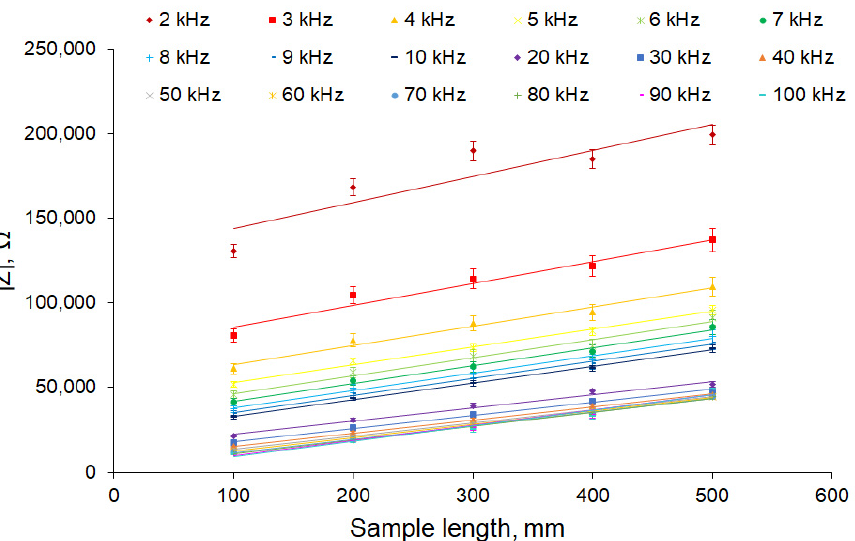
Figure 5. Dependence of the impedance modulus of apple samples on the sample length for different frequencies. The number of samples was 5 and the number of measurement repetitions was 5. Data are presented as mean values and standard errors.